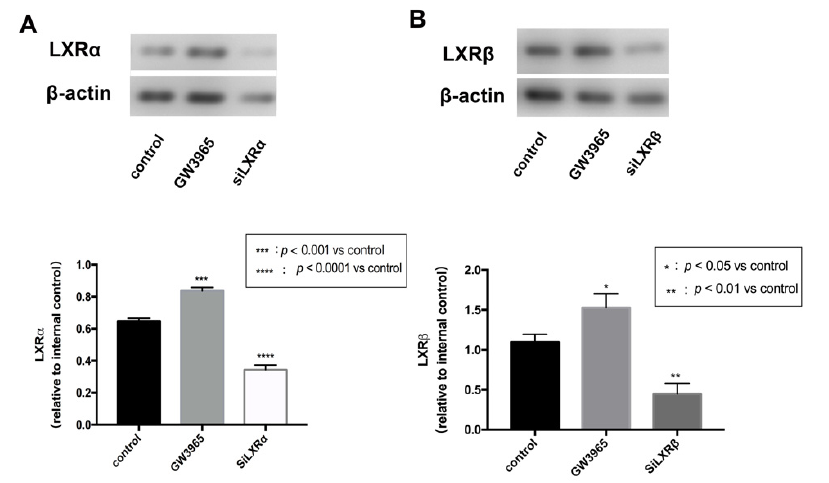
Figure 7. LXR activation in ARPE-19 cells. ( A ) LXR α expressions were detected by western blot and presented relative to controls. ( B ) LXR β expressions were detected by western blot and presented relative to controls. Data are represented as mean ± SEM of three independent experiments. Differences with p < 0.05 were considered statistically significant .